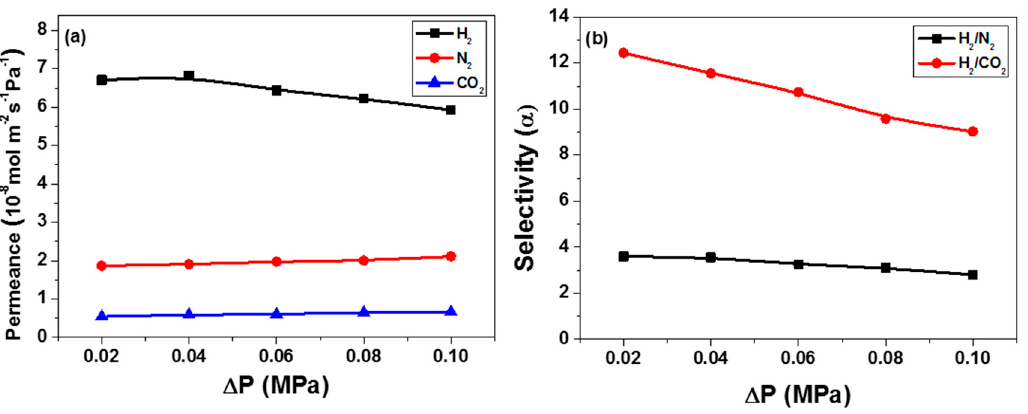
Figure 9. Gas permeance through the Co44-ZIF-8 membrane at different transmembrane pressure drops for ( a ) single gas permeance and ( b ) selectivity.